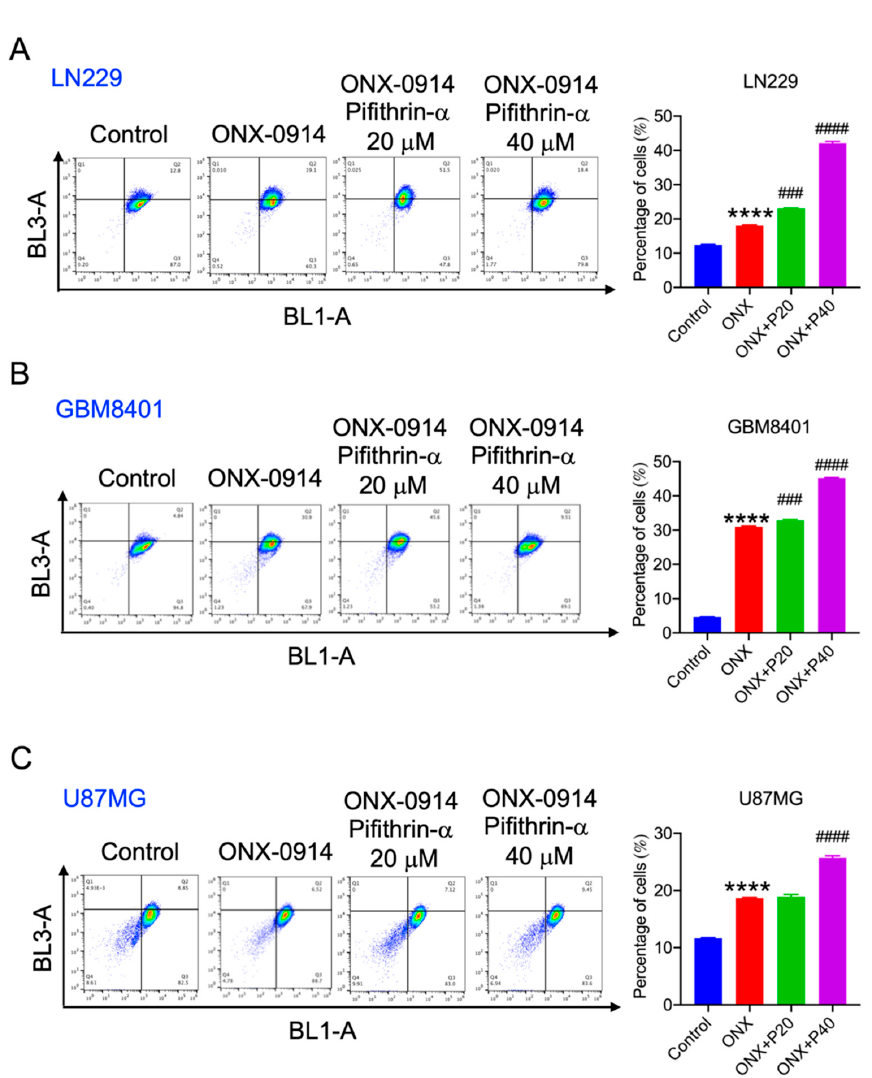
Figure 6. The effect of a p53 inhibitor on ONX-0914-induced autophagy in glioblastoma cells. Au- tophagy was detected using acridine orange staining. The flow cytometry results are shown in the dot diagram. The percentage of autophagic cells is shown in the bar diagram in the right panel; ( A ) LN229, ( B ) GBM8401, and ( C ) U87MG cells. ****, p < 0.0001 compared to the control group. ###, p < 0.001; ####, p < 0.0001 compared to the ONX-treated group.